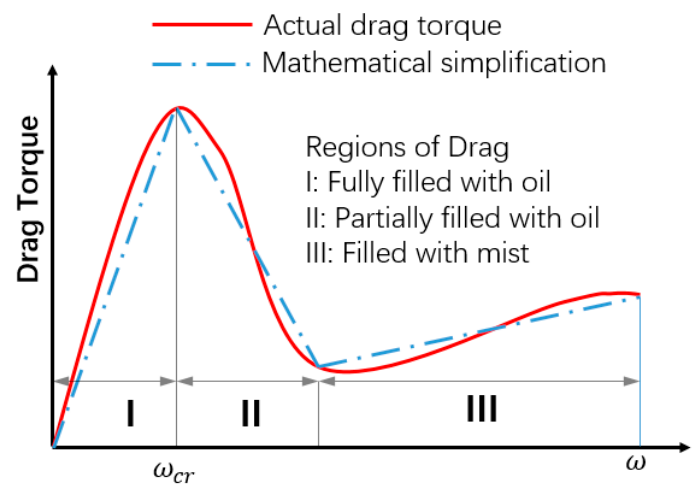
Figure 13. Drag torque versus relative rotational speed ω